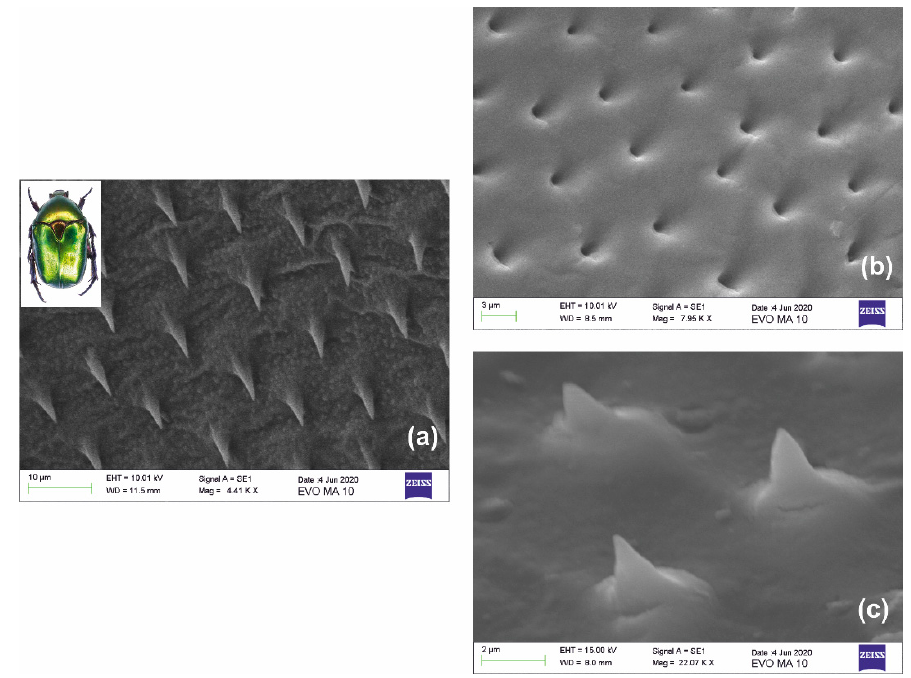
Figure 8. Miniaturization of a biomimetic structure: ( a ) SEM images of natural needles found in the wing shell of coleopteron protaetia cuprea phoebe (inset); ( b ) miniaturized negative replica of the structure in xerogel; and ( c ) miniaturized positive replica of the needles in xerogel. Both ( b , c ) have undergone SF ~4× maximum downsizing. The observed size of the apex of the conical needles is restricted by the intermediate replication stage and the electron microscope resolution limit.